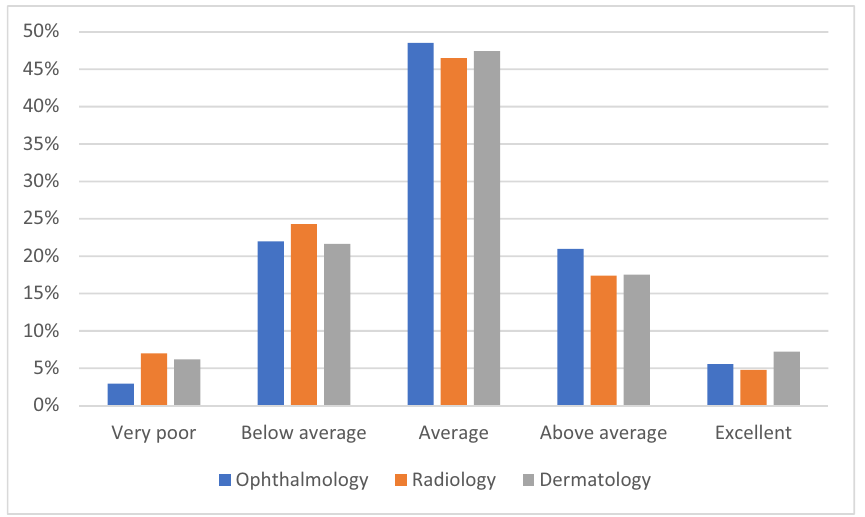
Figure 1. Self-reported knowledge of artificial intelligence and its application in the respondent’s specialty, relative to peers in that